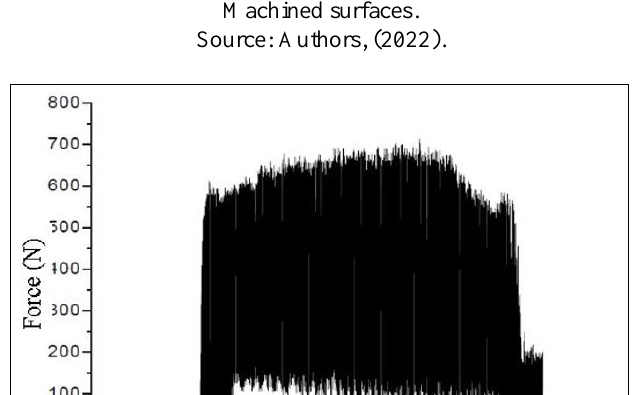
Figure 13a: Sample with sealant (nose radius 0,8 mm): (a) Machined surfaces.